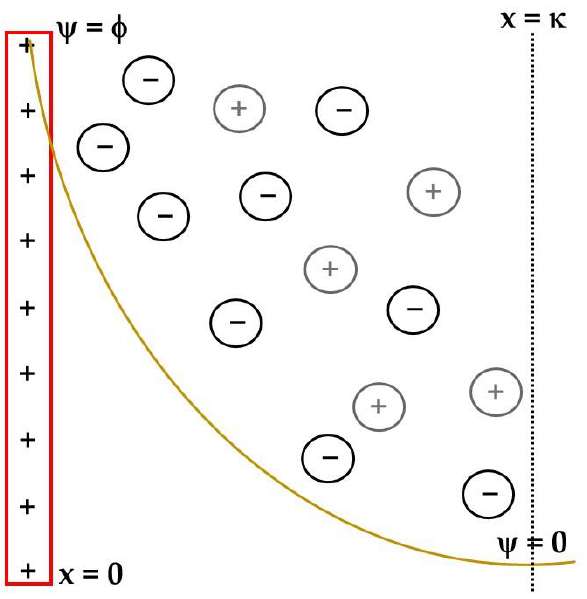
Figure 2. Gouy–Chapman electric double layer model. The electrode is represented as a red rectangle, and it is positively charged. The potential drop as a function of the distance from the surface is shown as a golden line and the Debye length as a dotted black line. The anions are represented as black circumferences and the cations as gray ones. The anion’s concentration is higher the smaller x, and the cations are bigger, both reaching the minima or maxima (in order) above κ , where the electrolyte behaves as a bulk phase.